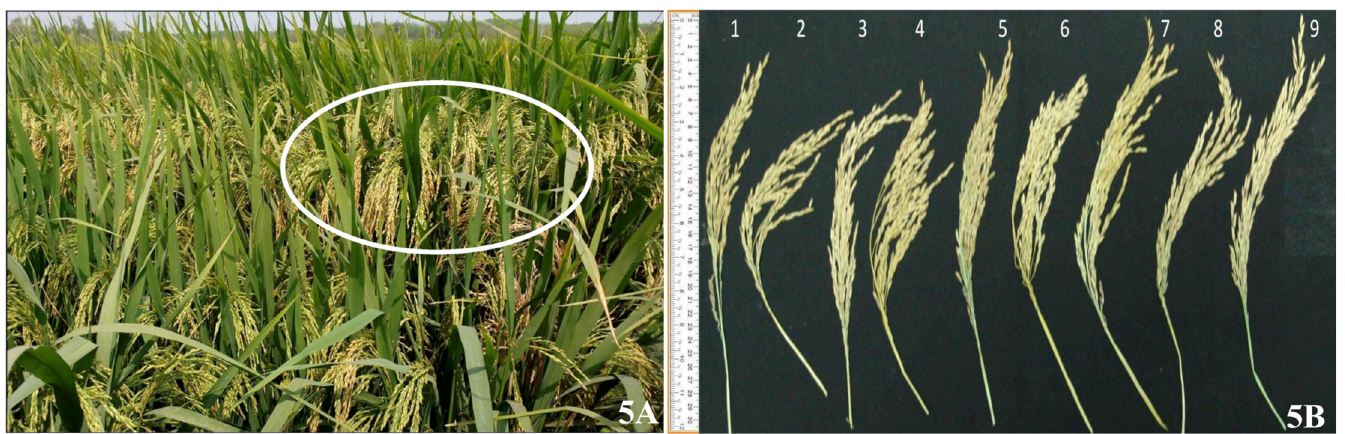
Fig 5. IL of DRR17B displaying high grain number under field conditions at IIRR, Panicles of ILs along with donor and recurrent parents. A. IL # IRIC102-26-27 displaying high grain number in field conditions, B. The ILs of DRR17B possessing Xa21 + Xa33 genes(# IIRRIC10-8-94, IIRRIC10-19-138, IIRRIC102-26-7, IIRRIC123-34-84, IIRRIC123-58-3, and IIRRIC172-77-12)were displayed more number of grains per panicles and similar panicle length (except number 6) when compared with DRR17B.